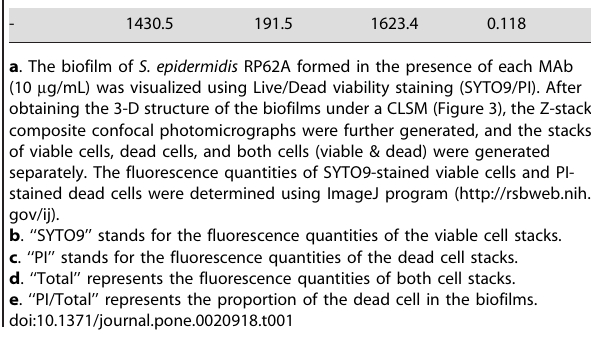
(Figure 5), whereas, notably, planktonic cells co-cultured with Table 2). Bacteria in superficial layers of the MAb-treated biofilms Table 3), whereas the Aap expression of bacteria in profound